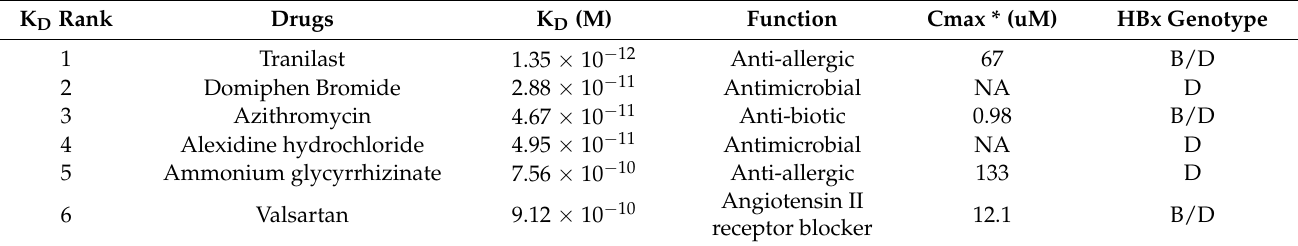
Table 1. Hit compounds showing HBx binding signal by SPRi screening.